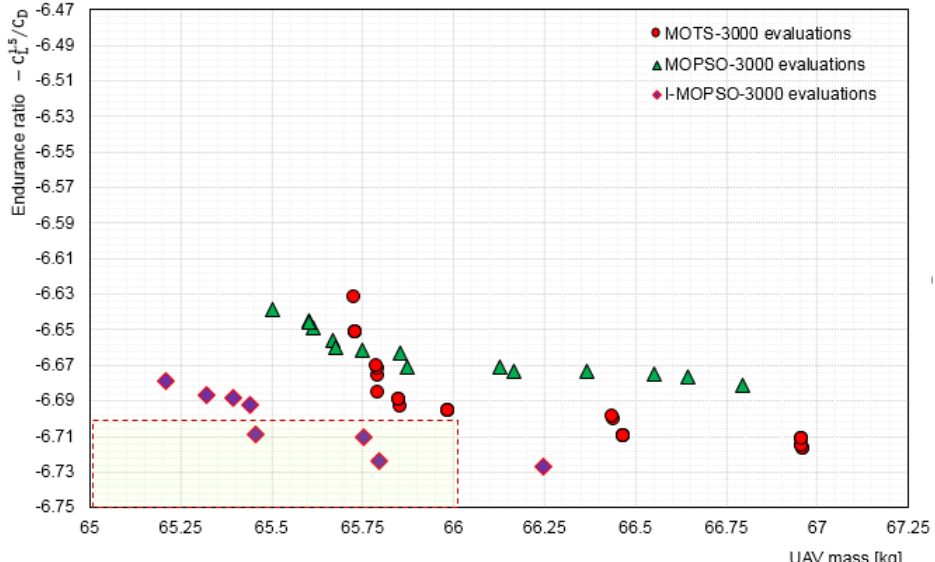
Figure 16. Comparison of Pareto front using MOTS and MOPSO with I-MOPSO, each using 3000 evaluations. Note the superiority of using interactive optimisation.